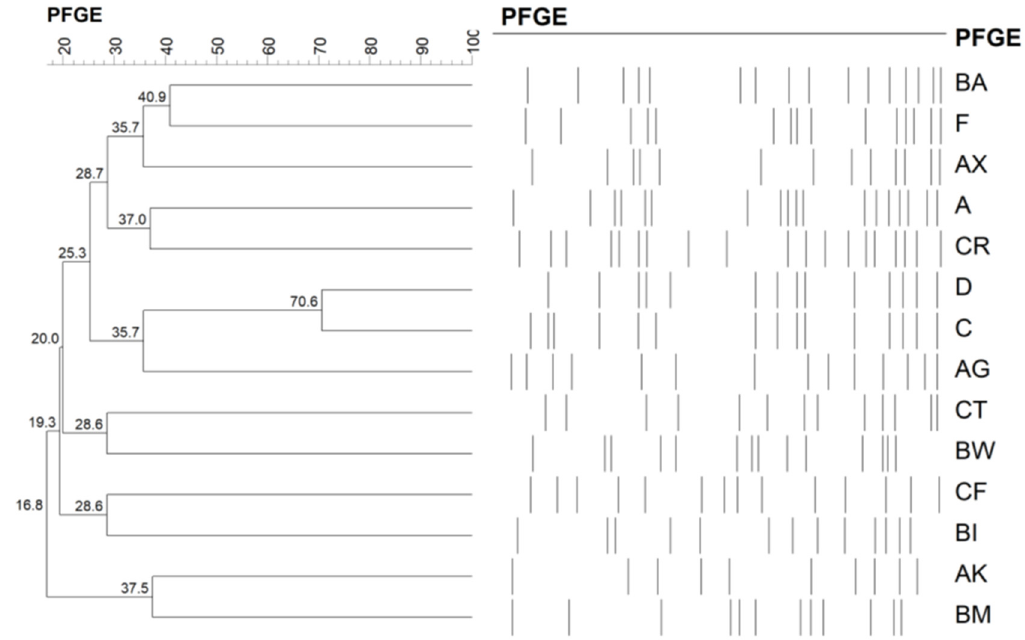
Figure 1. Dendrogram of pulsed-field gel electrophoresis cluster analysis of 104 methicillin-susceptible Staphylococcus aureus ocular isolates, classified into 14 pulsotypes.